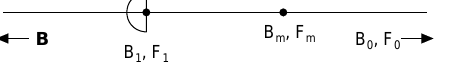
Figure 7. Sketch of a magnetic field line with values of magnetic field magnitudes B and hemispheric fluxes F at several locations. Further explanation is given in the text.